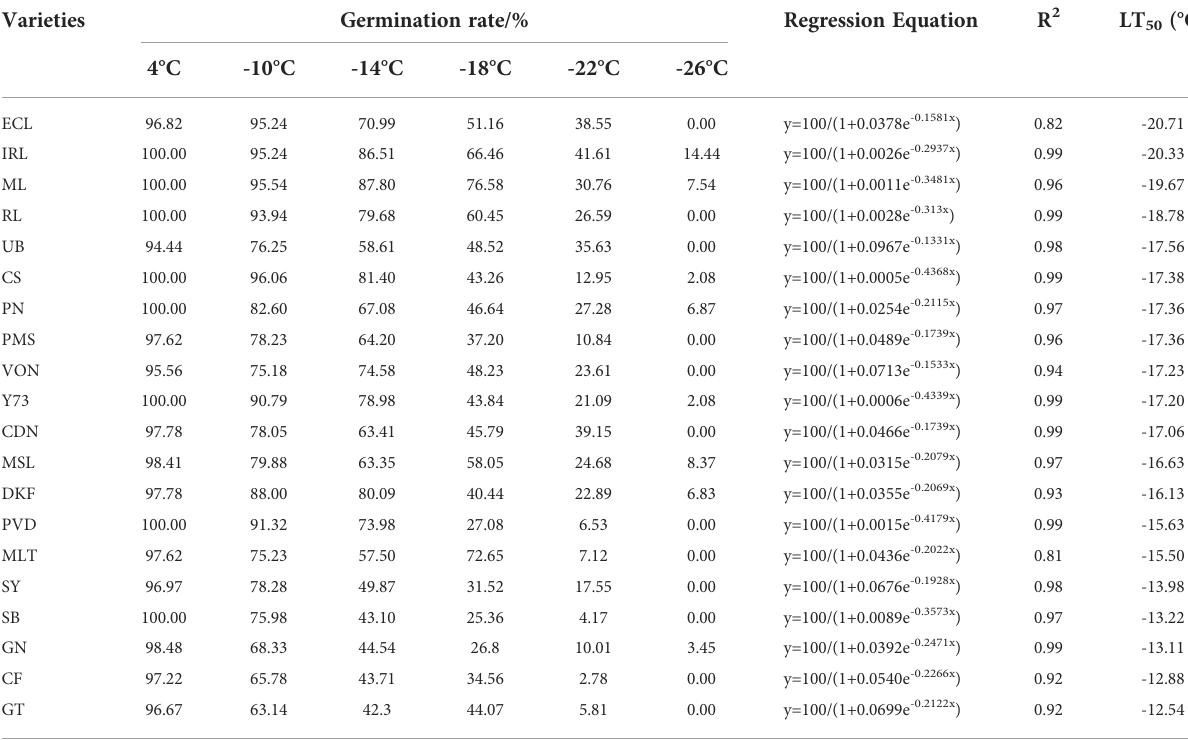
Varieties Germination rate/%